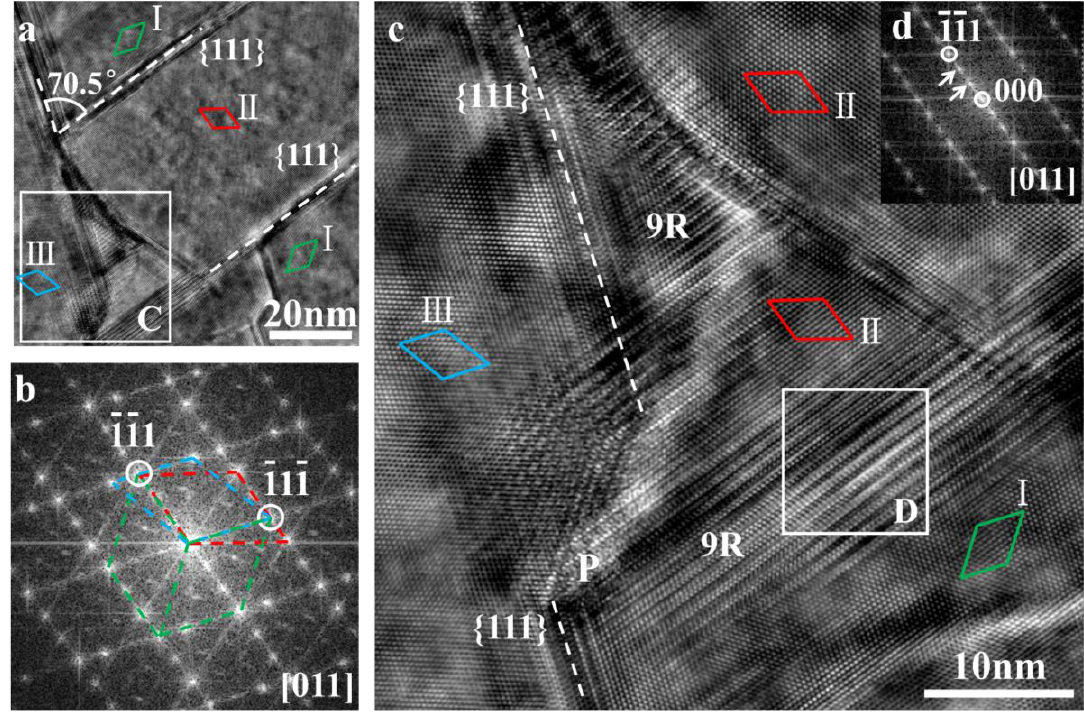
Figure 4. The 9R structure is located at the intersection of multiple {111} twins in modified eutectic Si. ( a ) The HRTEM image of the region R2 in Figure 1c with multiple twins; ( b ) The corresponding FFT pattern of ( c ); ( c ) The magnification image of region C; ( d ) The FFT pattern of region D.